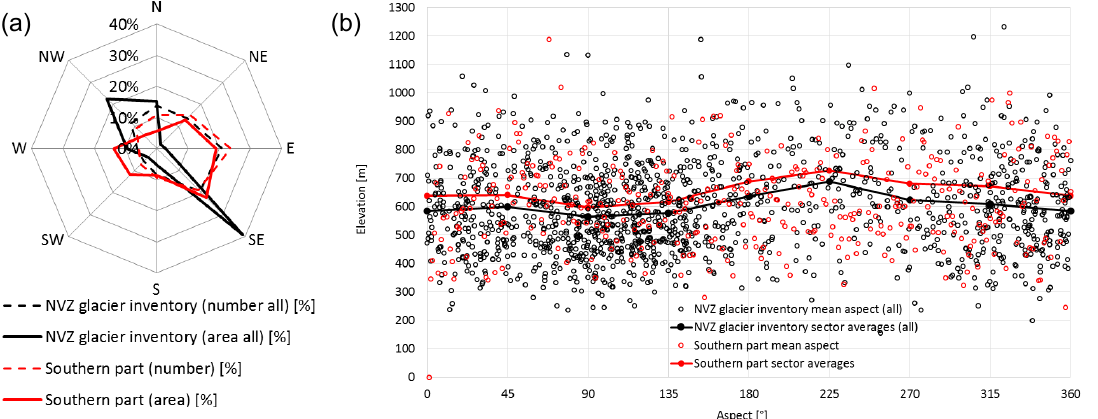
Figure 7. ( a ) Area and number distribution versus aspect for the whole island and the southern part only; ( b ) mean elevation vs. glacier aspect and sector averages for the same sub-sets.